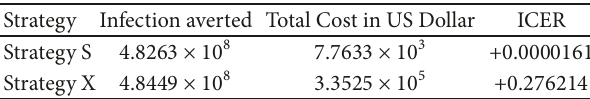
Table 6: The cost and infection averted for controls S and X. Strategy Infection averted Total Cost in US